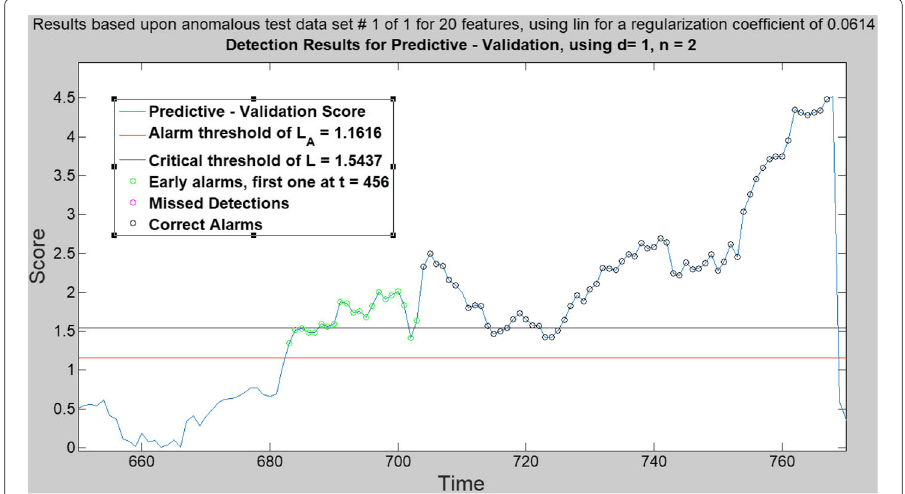
is negative to make the CO2-level spikes positive) - this creates gradually evolving spikes in the CO2-level in the four rooms, see Figs. 6 and 7.